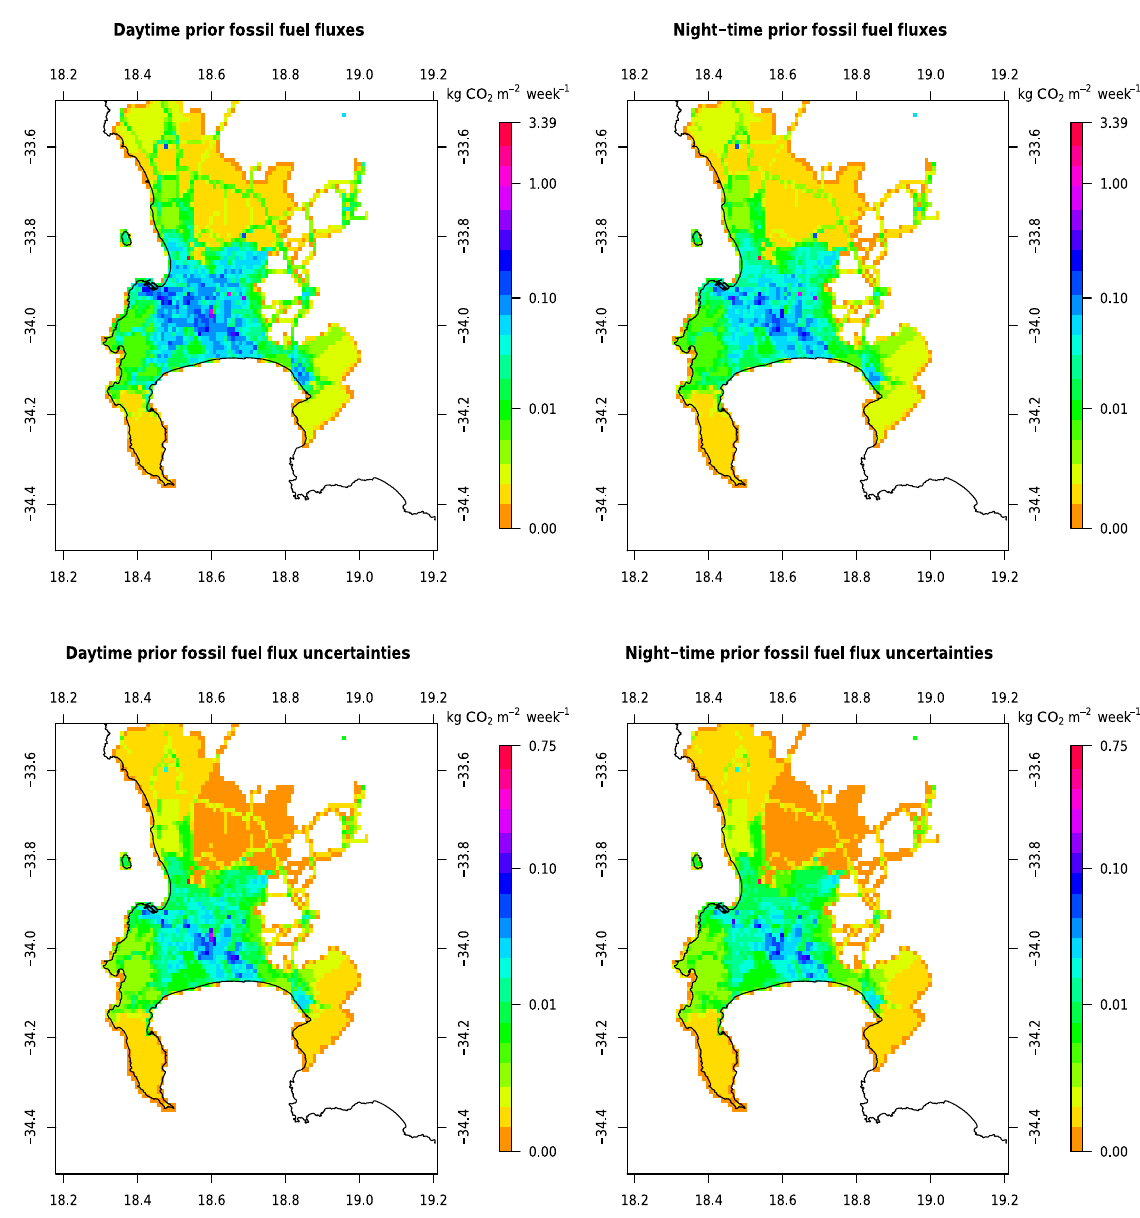
Figure 3. Prior estimates for day- and night-time fossil fuel fluxes (kg CO 2 m − 2 week − 1 ) and the corresponding uncertainties, expressed as standard deviations (kg CO 2 m − 2 week − 1 ), for the month of March 2012. These estimates were derived from an inventory analysis for CT based on vehicle, aviation, and shipping vessel count data, population census data, and fuel usage at industrial point sources. White indicates regions where the fossil fuel flux and its uncertainty are set to zero. These prior estimates are provided at a resolution of 1km × 1km and the extent of the grid is between 34.5 and 33.5 ◦ S and between 18.2 and 19.2 ◦